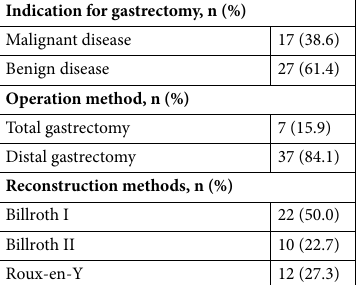
Indication for gastrectomy, n